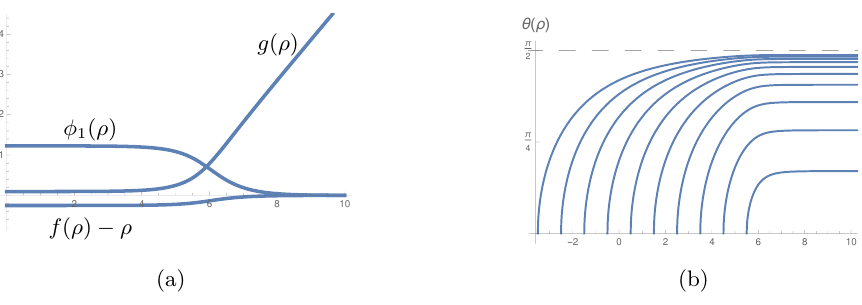
Figure 9 . Left: RG flow solution for N = 4 SYM on S 2 with a 1 = a 2 = 2 . Right: minimal surfaces; surfaces starting close to the equator in the UV reach into the IR. The scaling dimensions in the IR solution are